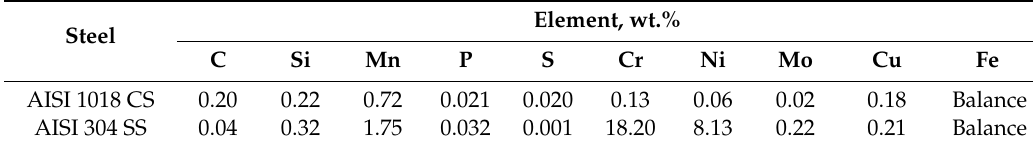
Table 5. Elemental composition (wt.%) by X-ray fluorescence spectroscopy (XRF) analysis of the